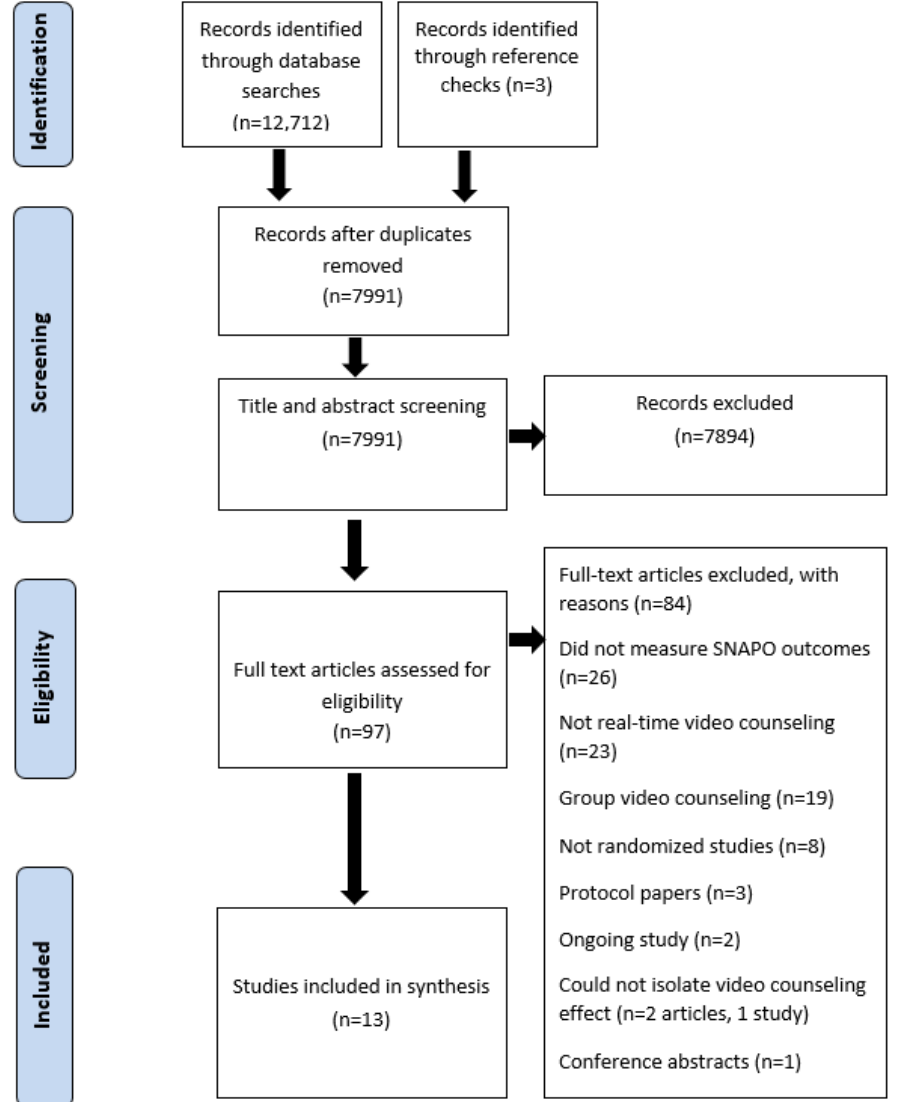
Figure 1. PRISMA (Preferred Reporting Items for Systematic Reviews and Meta-Analyses) diagram of the screening and selection process. SNAPO: smoking, nutrition, alcohol consumption, physical activity, and